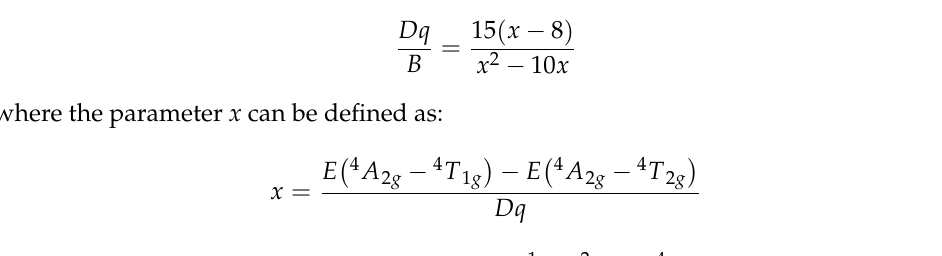
On the basis of the peak energy (15,873 cm − 1 ) of 2 E g → 4 A 2 g transition obtained from the emission spectrum, the Racah parameter C can be evaluated from the expression: